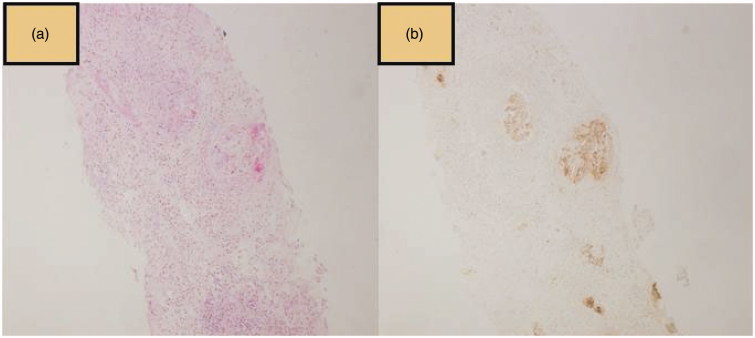
Hematoxylin eosin (a) and immunohistochemically mTOR (b) stained images of the crescentic glomerule.